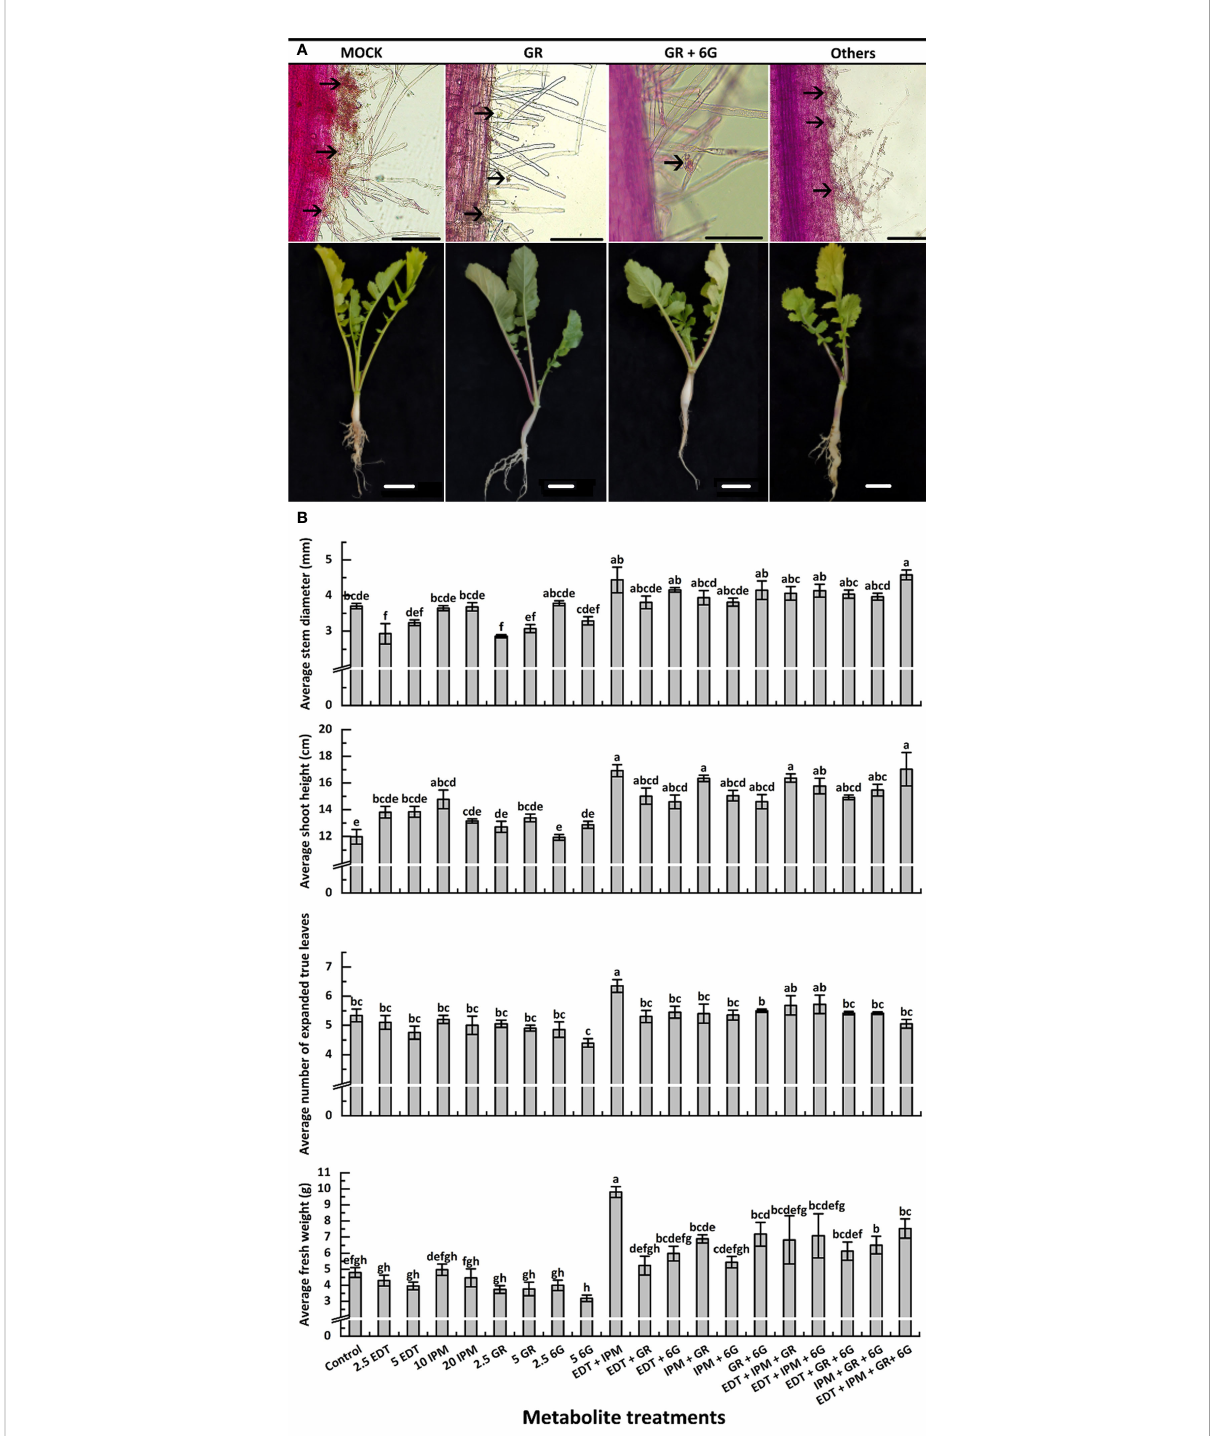
FIGURE 4 Effects of metabolites on root club formation of diseased “ JNYB ” seedlings (A) and growth of infected seedlings (B) . “ other ” in (A) refers to other treatments; for details, see Supplementary Figures 5 – 8. The fi rst line indicates the growth of P. brassicae within the root hair of radish 24 h after inoculation with resting spores; the second line exhibits the clubroot disease incidence in radish tap root in the cortex splitting stage. Black arrows in (A) indicate spores. Scale bar in fi rst and second lines equals to 100 m m and 1 cm, respectively. Data in (B) are presented by mean value ± SE. A total of 20 randomly selected samples were treated and measured in each replication. Three replications were conducted. Letters indicate signi fi cant differences. Signi fi cant differences were analyzed on P <